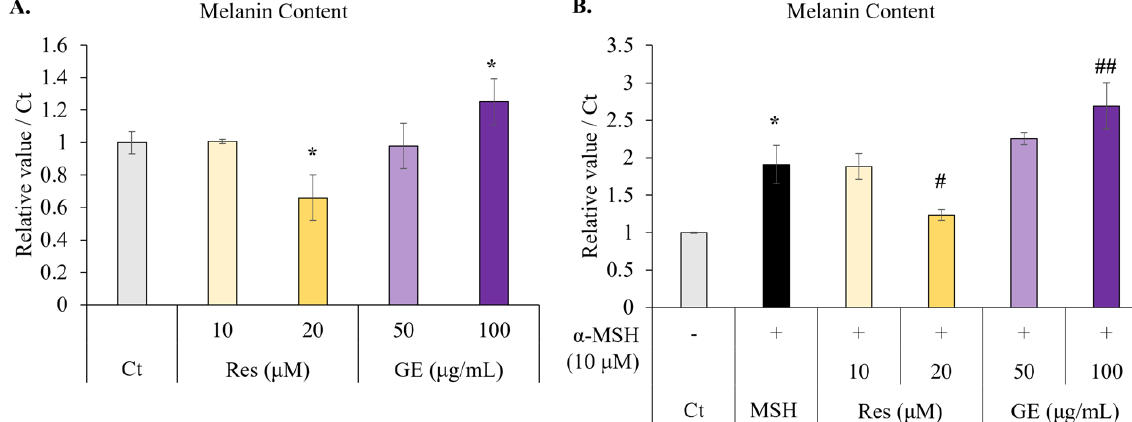
Figure 2. Effect of 72 h treatment with resveratrol (Res; 10 μM or 20 μM ) and grape extract (GE; 50 μg/m L or 100 μg/m L) on melanogenesis in B16F10 melanoma cells. The positive control for melanin synthesis was α -melanocyte-stimulating hormone ( α -MSH). The absorbance at a wavelength of 405 nm was measured after 72 h. The relative melanin content was normalized to the total protein content of the cell. ( A ) The melanin content in cells without α -MSH stimulation. ( B ) The melanin content in cells stimulated with α -MSH ( 10 μM ). The results are indicated as the mean ± standard deviation, n ≥ 3. * p < 0.05 vs. Ct (non-treatment), # p < 0.05, ## p < 0.01 vs. α -MSH.